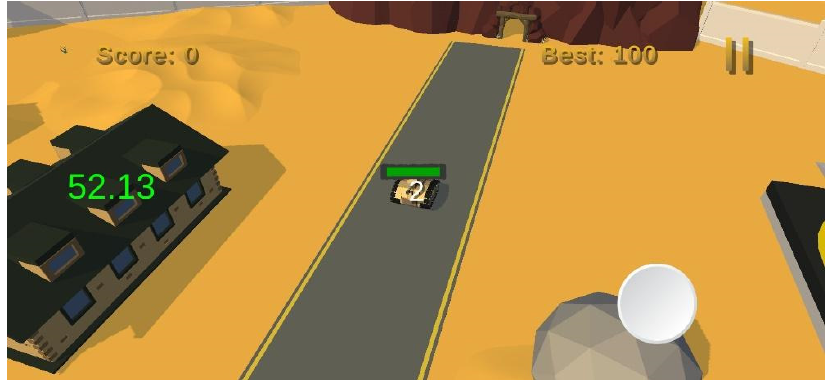
Figure 17. Beginning of the non-optimized version of the game.